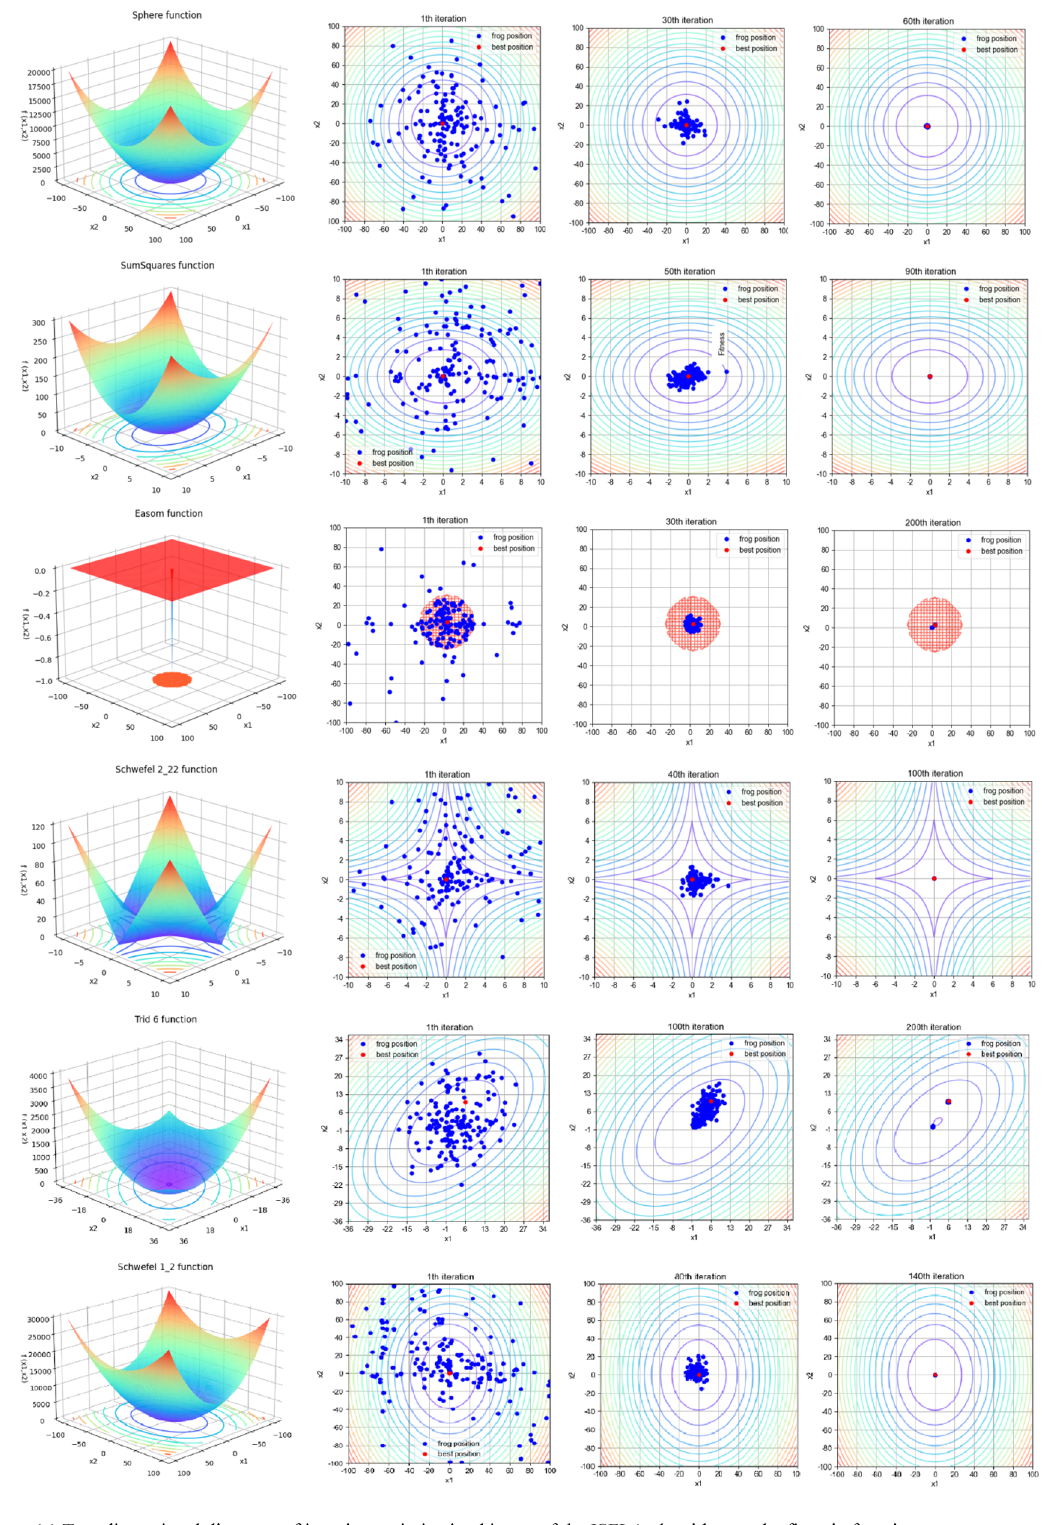
Fig. 4 a Two-dimensional diagrams of iterative optimization history of the ISFLA algorithm on the first six functions. b Two-dimensional diagrams of iterative optimization history of the ISFLA algorithm on